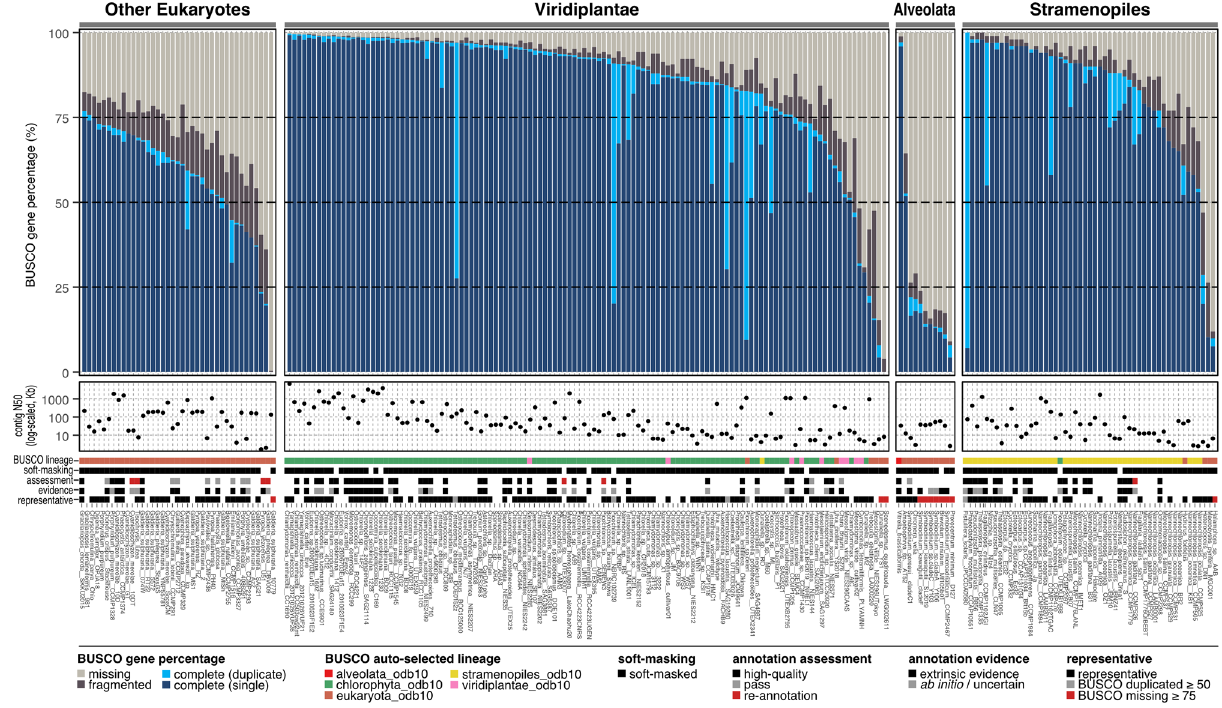
Figure 2. BUSCO assessment results of genome assemblies. The top panel displays BUSCO genome assessment with the automatically selected BUSCO lineages. The second panel displays log-scaled contig N50 values. Each row of the third panel illustrates information described in Supplementary Table S1. BUSCO lineage row displays automatically selected BUSCO lineages during BUSCO genome assessment. Soft-masking row displays whether the genome is soft-masked or not. Assessment row displays BUSCO protein assessment result of the structural annotation. Evidence row displays evidence used for annotation of the official gene set. Representative row indicates whether the genome is representative genome among closely related